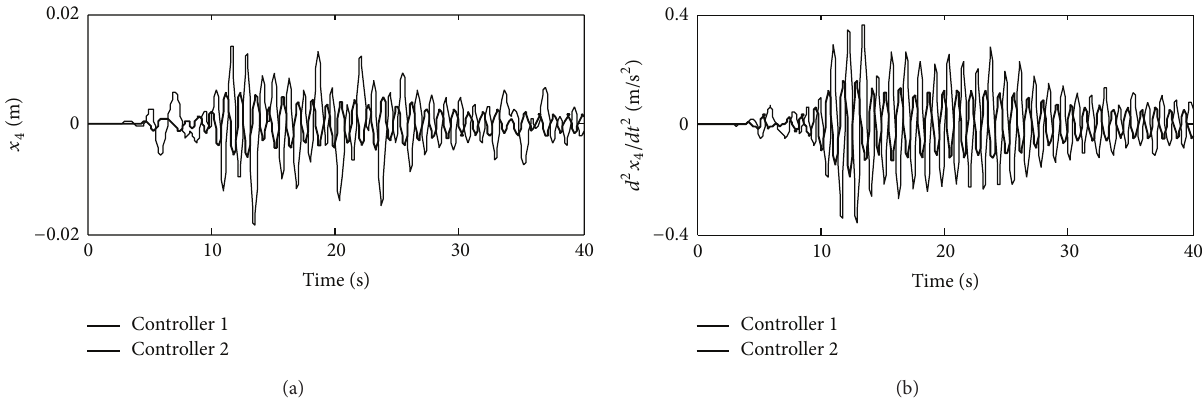
Figure 11: Comparison of time responses of the 𝑥 4 for controllers cases (Northridge earthquake).